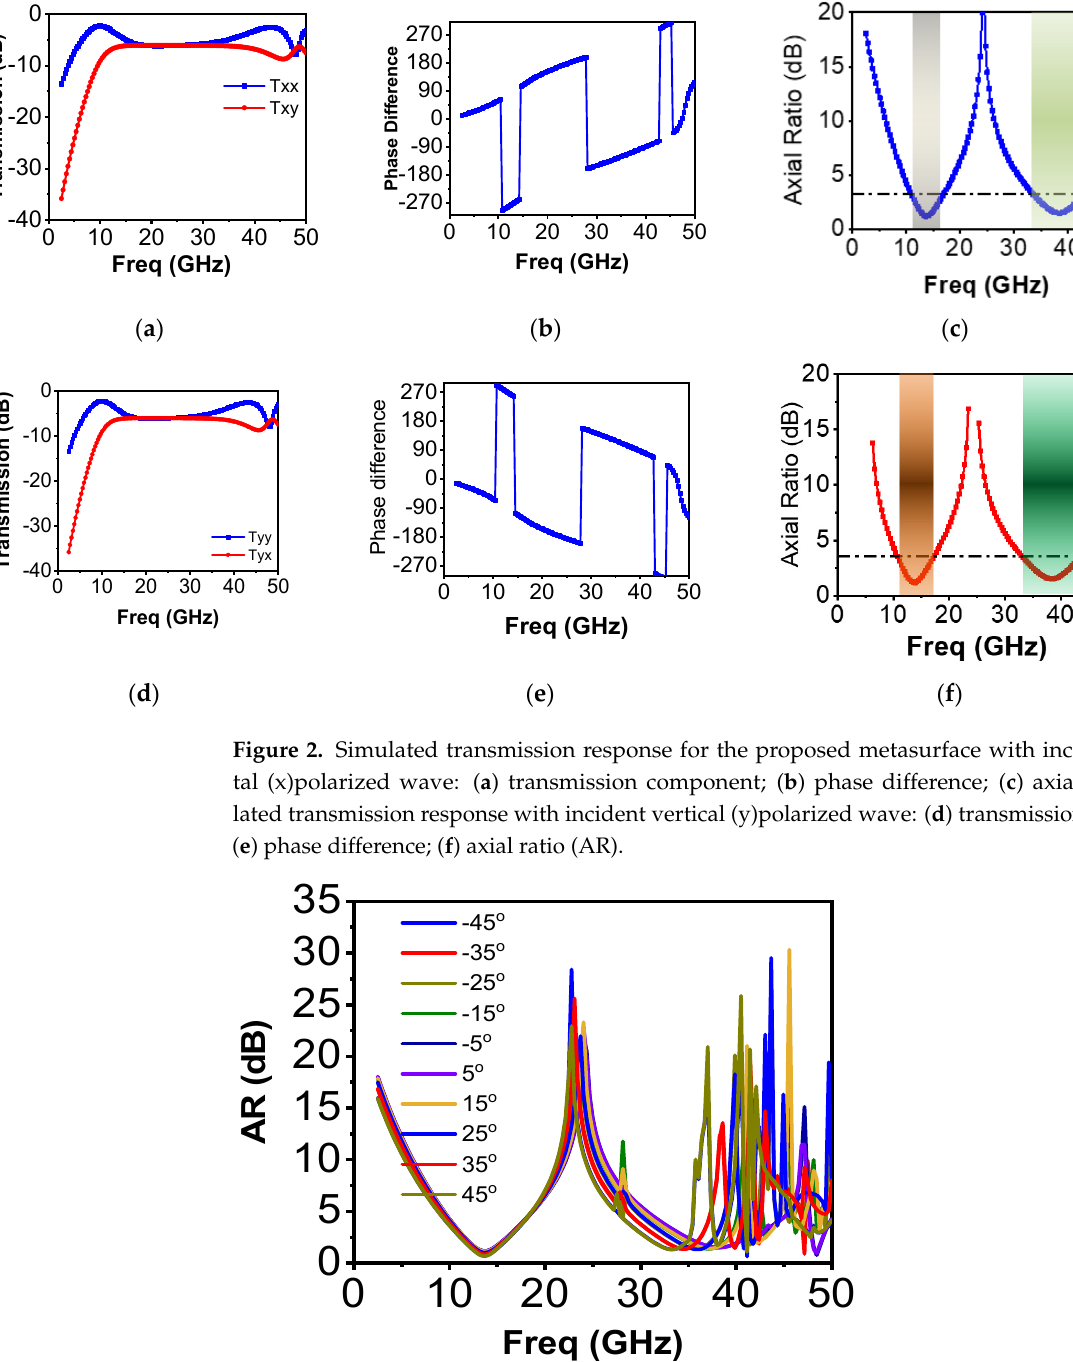
Figure 3. Simulated response for oblique incidences.